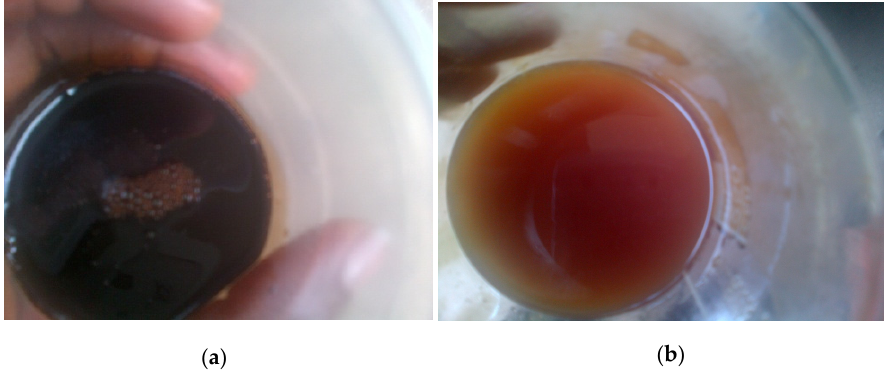
Figure 1. ( a ) Solvent extraction and ( b ) Adsorption process with activated charcoal.